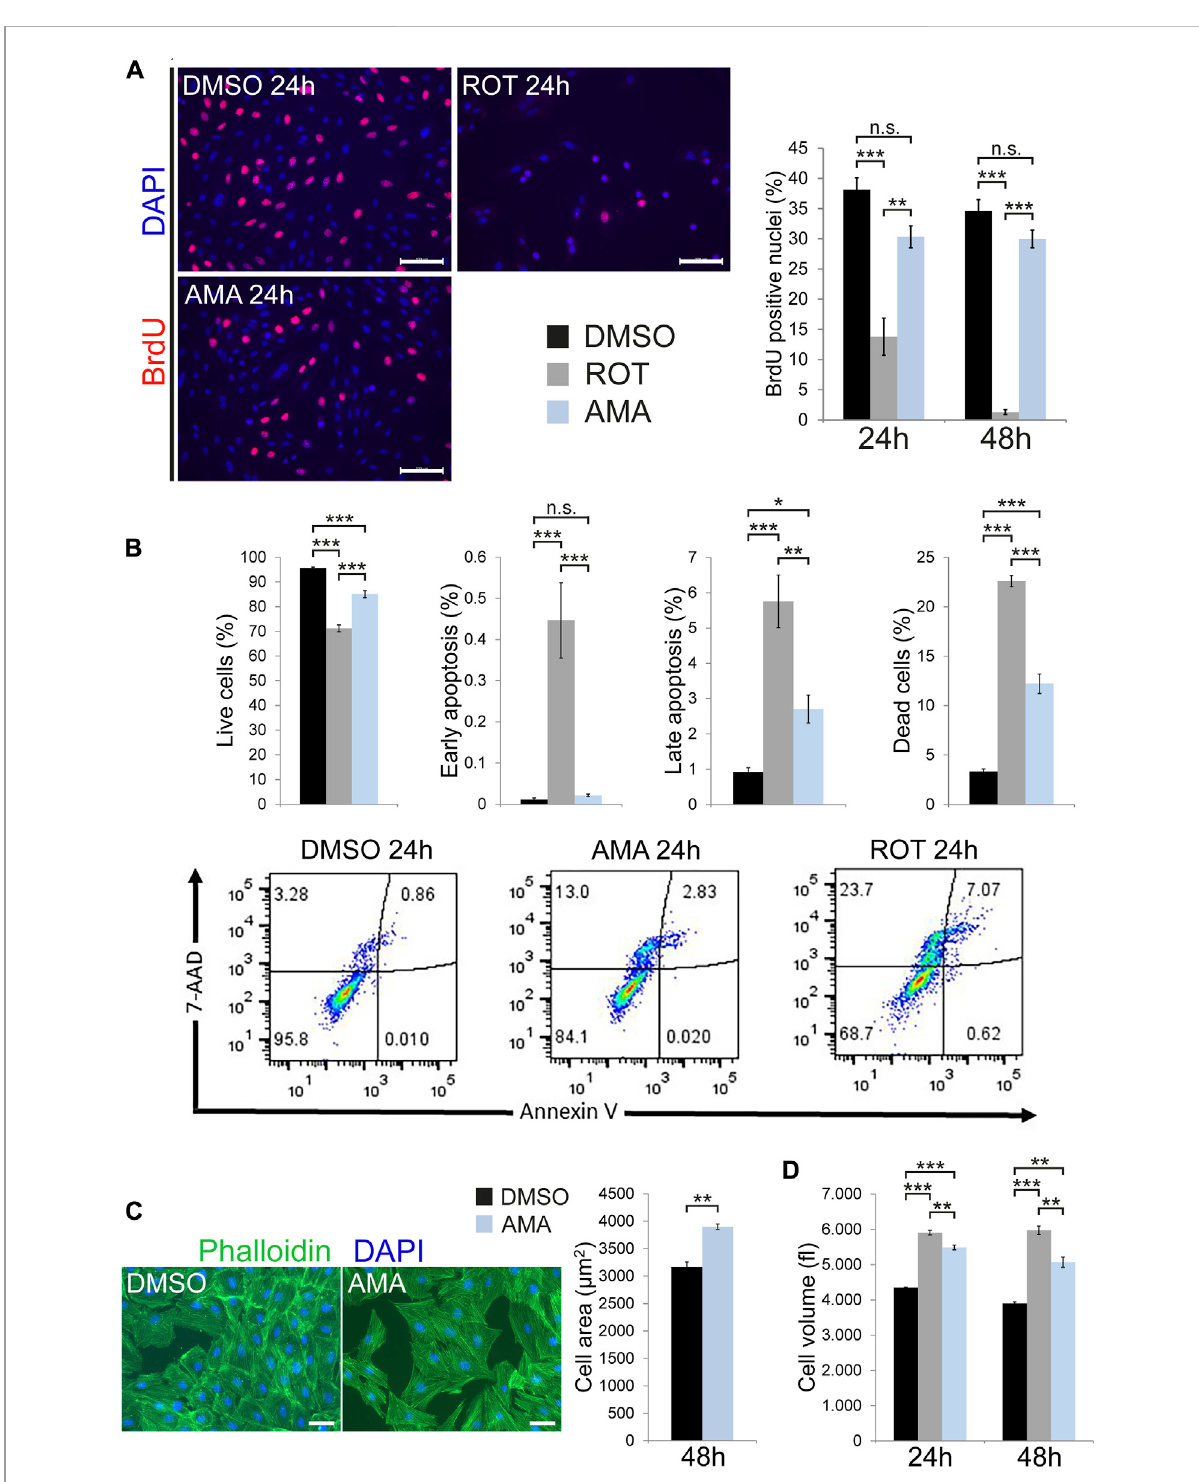
FIGURE 2 Apoptosis,cellcycleactivityandcellsizeinH9c2cellstreatedwithinhibitorsofmitochondrialrespiration. (A) Fluorescencemicroscopyimages showing BrdU incorporation in H9c2 cells treated with DMSO, AMA(50 µM) or ROT(10 µM) for 24 h. Cell cycleactivitywas evaluated as thenumber of BrdU positive nuclei (stained in red) related to the overall number of nuclei (stained in blue using DAPI, n = 3 wells per treatment, scale bar = 100 µm). (B) CelldeathwasdeterminedinDMSO, AMAandROTtreatedH9c2cellsafter24 husingAnnexin Vand7-AADstainingincytometry. Annexin V positive but 7-AAD negative cells were considered to represent early apoptosis whereas double positive cells represent late apoptosis. 7-